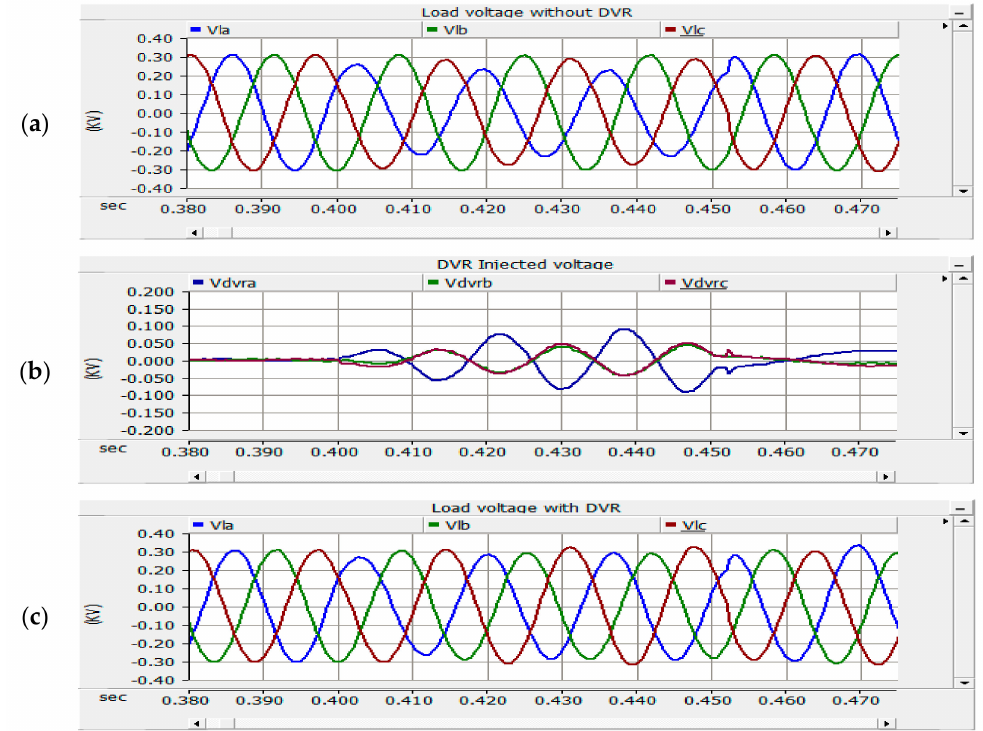
Figure 12. 30% single phase voltage sag and compensation: ( a ) load voltage without DVR; ( b ) DVR injected voltage; ( c ) load voltage with